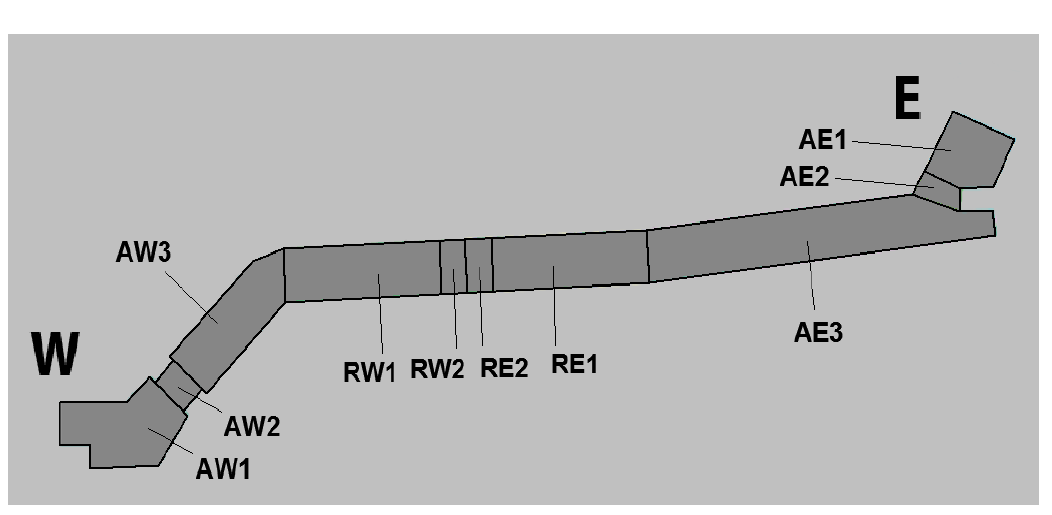
Table 8. LOS range related to RAMP and AREA.